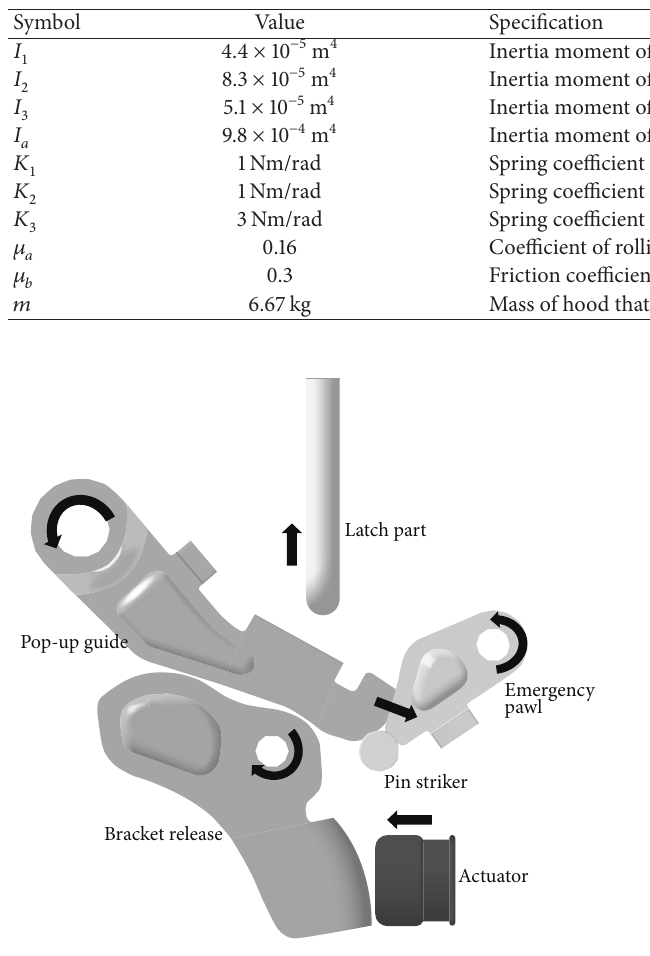
Figure 2: Schematic configuration of